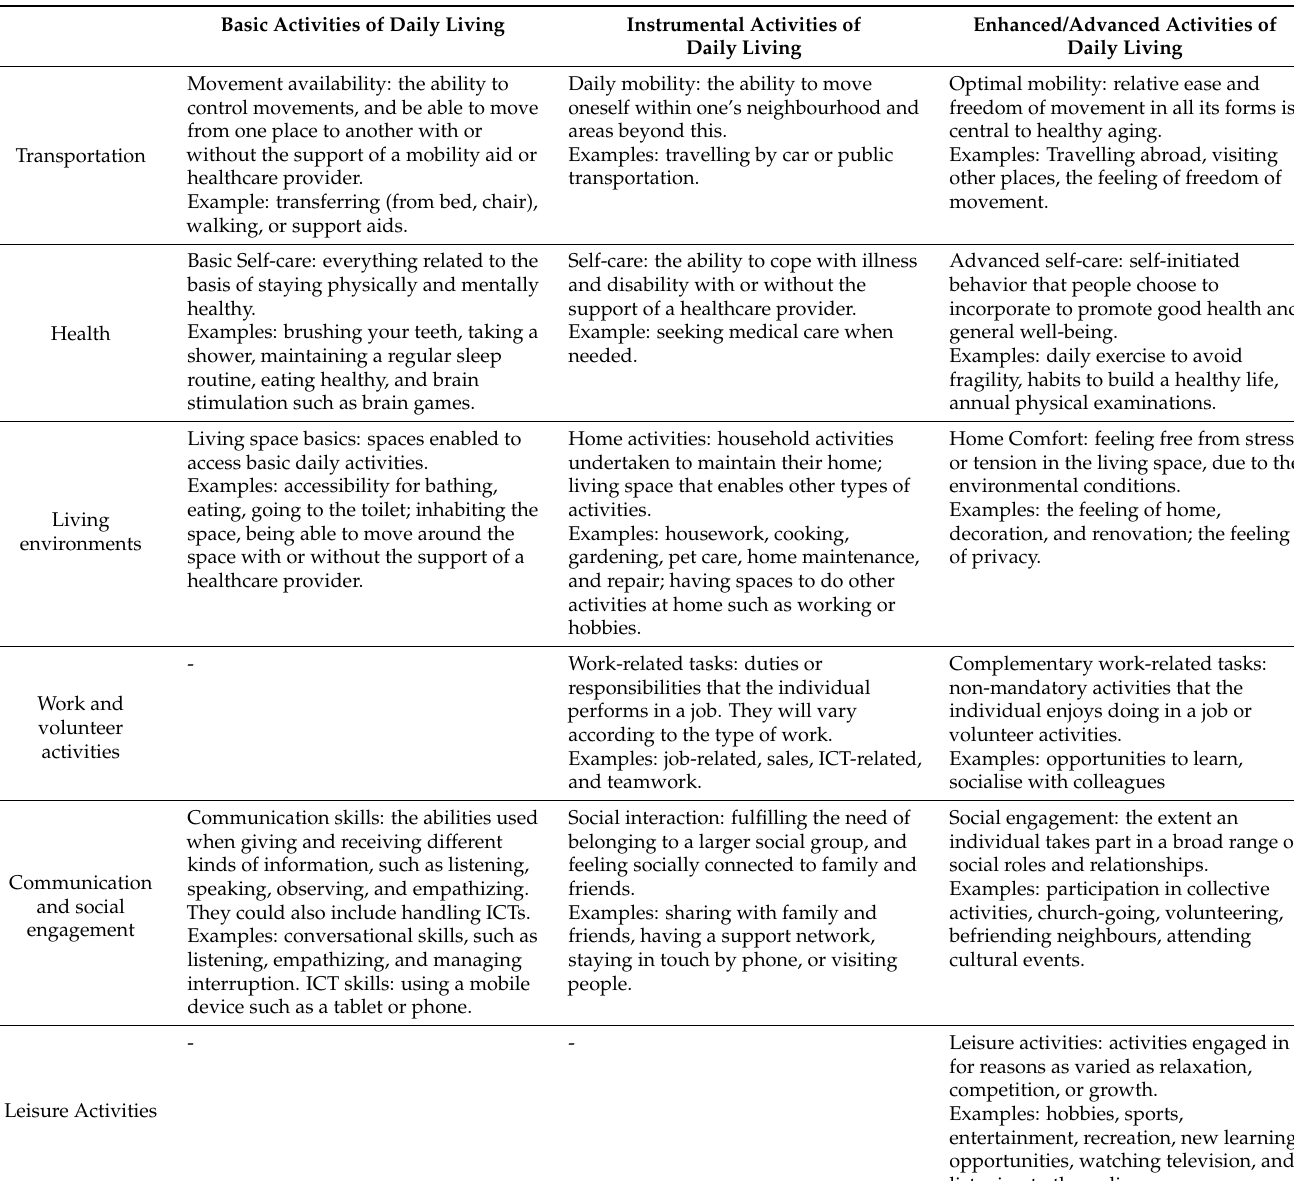
Table 3. Relationships between frameworks and data